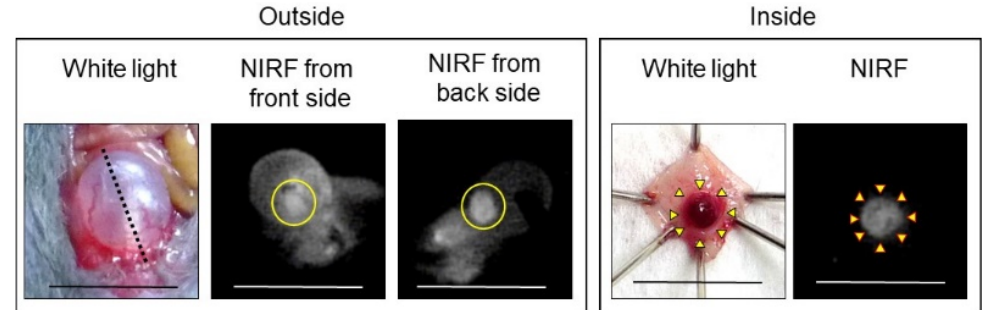
Figure 8. Representative near-infrared fluorescence (NIRF) imaging of MB49 bladder cancer after intravesical administration of ASP5354. ASP5354 (2.4 μ M) was injected in cancerous bladder, 5 min post which, the cancerous bladder was rinsed with saline 5 times, filled up with saline, and NIRF images were obtained from front and back sides of the bladder. After imaging, the bladder was picked out, opened along the black dotted line, and NIRF in the obtained bladder inner layer was imaged. All excitation levels are 10 a.u. NIRF is displayed in white. Scale bar represents 10 mm. Bladder cancer is circled with yellow line. Yellow arrows show points of boundary between NIRF and non-NIRF.